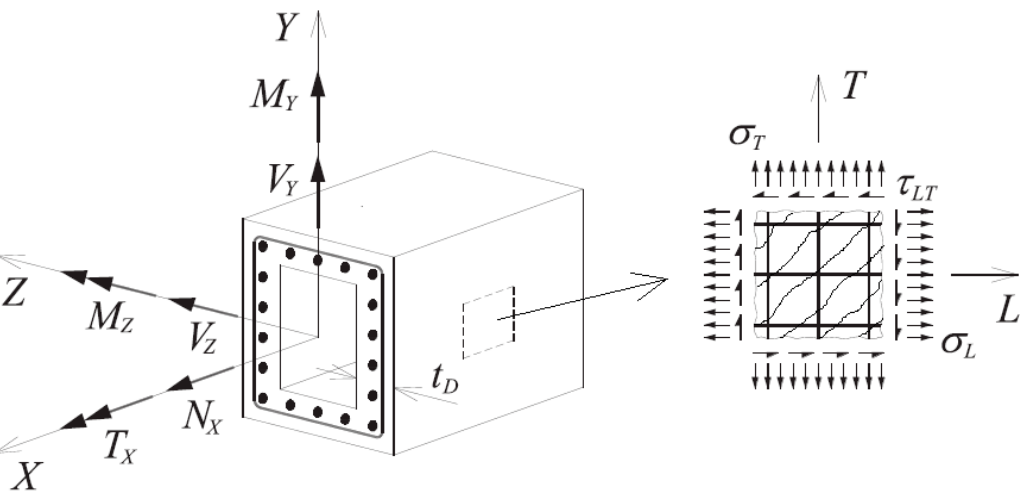
Figure 3. Idealization of the RC member according to the CA-STM.